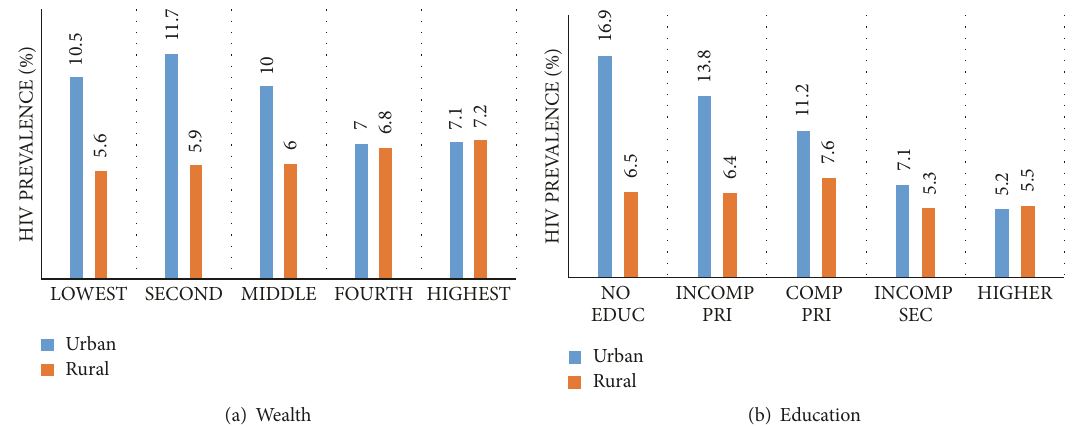
Figure 1: HIV prevalence by household wealth status (a) and educational attainment (b) in rural and urban areas, UAIS, 2004-2005 and 2011 ( 𝑛 = 39 , 767